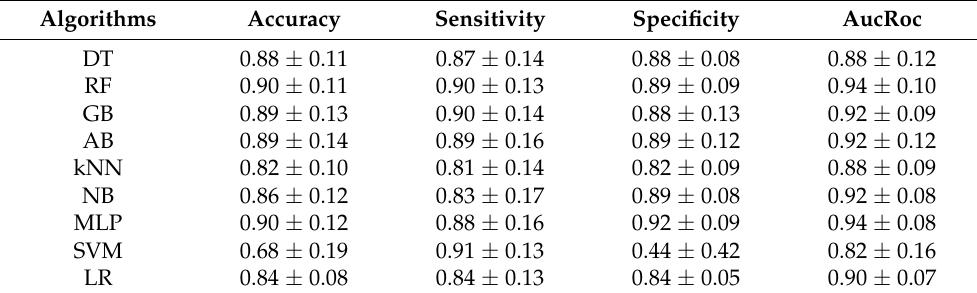
Table 4. Scores from stratified tenfold CV evaluation metrics averaged over the seven subjects (mean ± standard deviation) using the features extracted from the angular velocity signals along the three